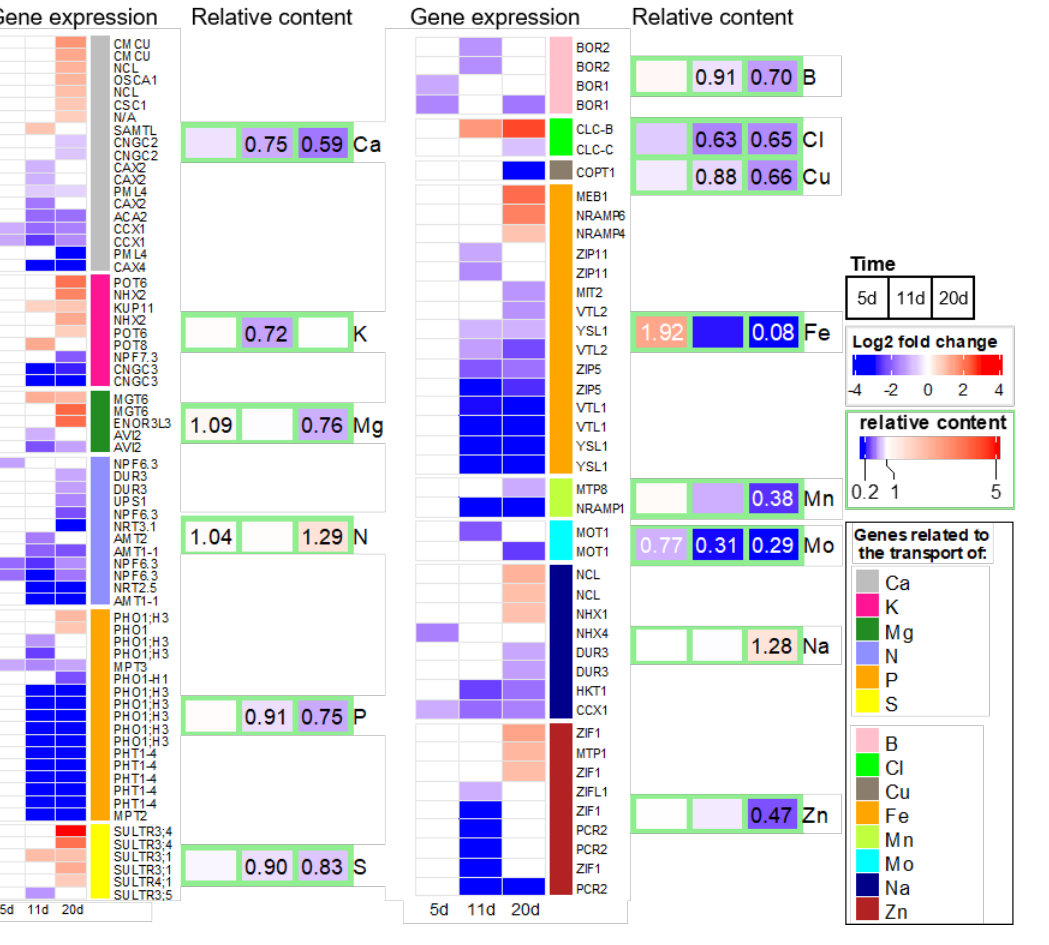
Figure 8. Expression profiles of 114 genes encoding macronutrient ( A ) or micronutrient ( B ) trans- porters and changes in mineral nutrient contents in leaves of B. napus exposed to 5, 11, and 20 d of water deficit, relative to control plants. Log2 fold changes in DEGs are colored in red (up) or blue (down), and non-significant variations in gene expression are blank (adjusted p -value < 0.05). Boxes indicate the relative content of nutrients as the ratio WD/control, and only significant variations are reported.